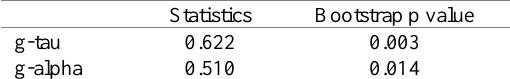
Table 16. Cointegration test results of Model 3